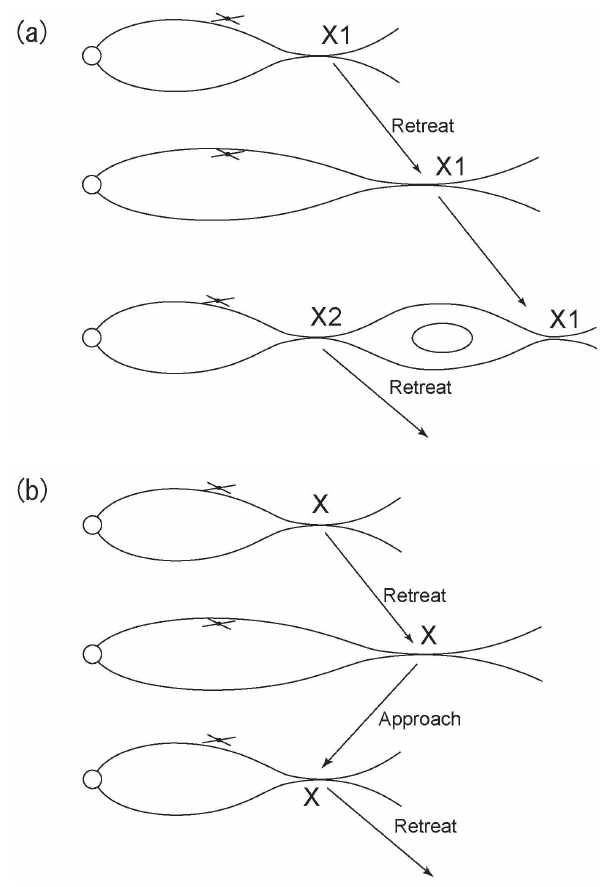
Fig. 7. Schematic picture of two possible neutral line motion sce- narios. (a) Zigzag motion between the near-Earth region and mid- tail region, (b) formation of plural X-lines by successive reconnec-